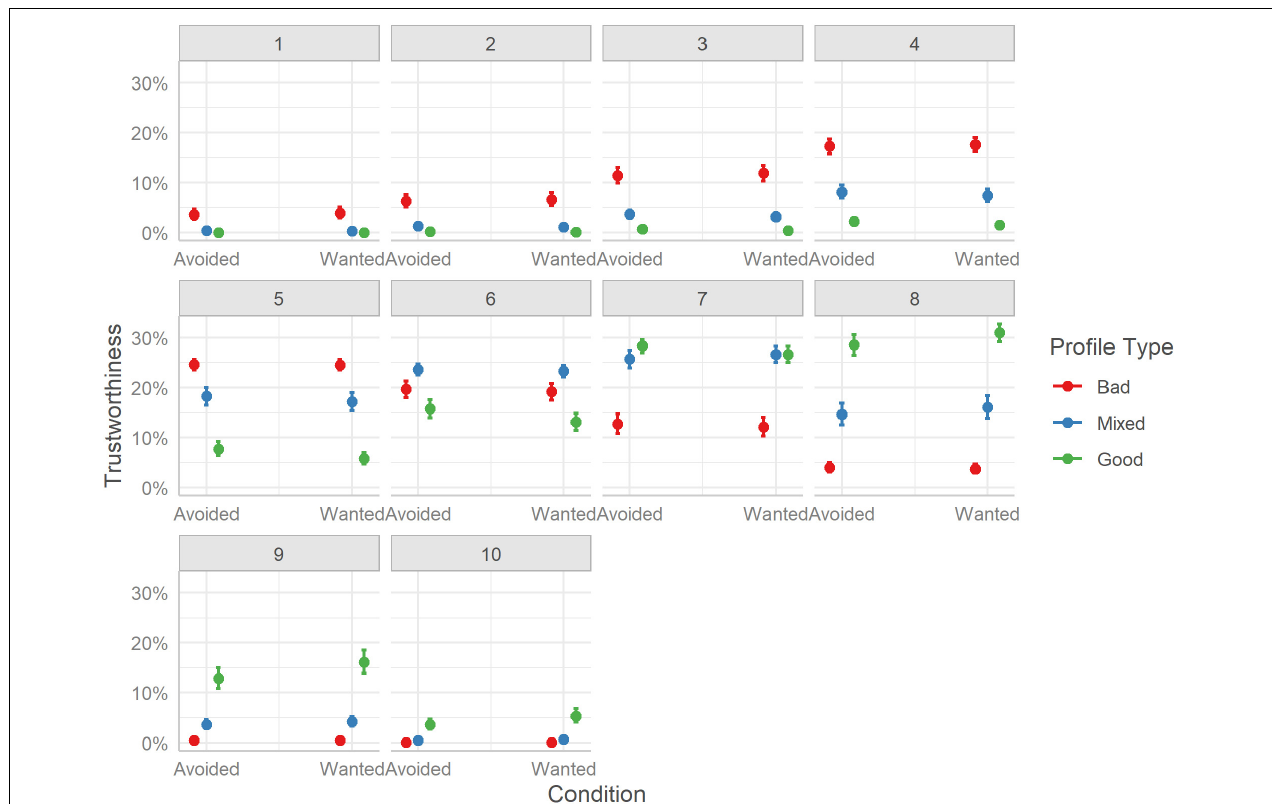
FIGURE 14 | Marginal effects of trustworthiness. The posterior mean estimates of the probability of responses in each of the three Profiles (Bad, Good, Mixed) by the two experimental Conditions (Avoided or Wanted). Error bars indicate 95% credible intervals.